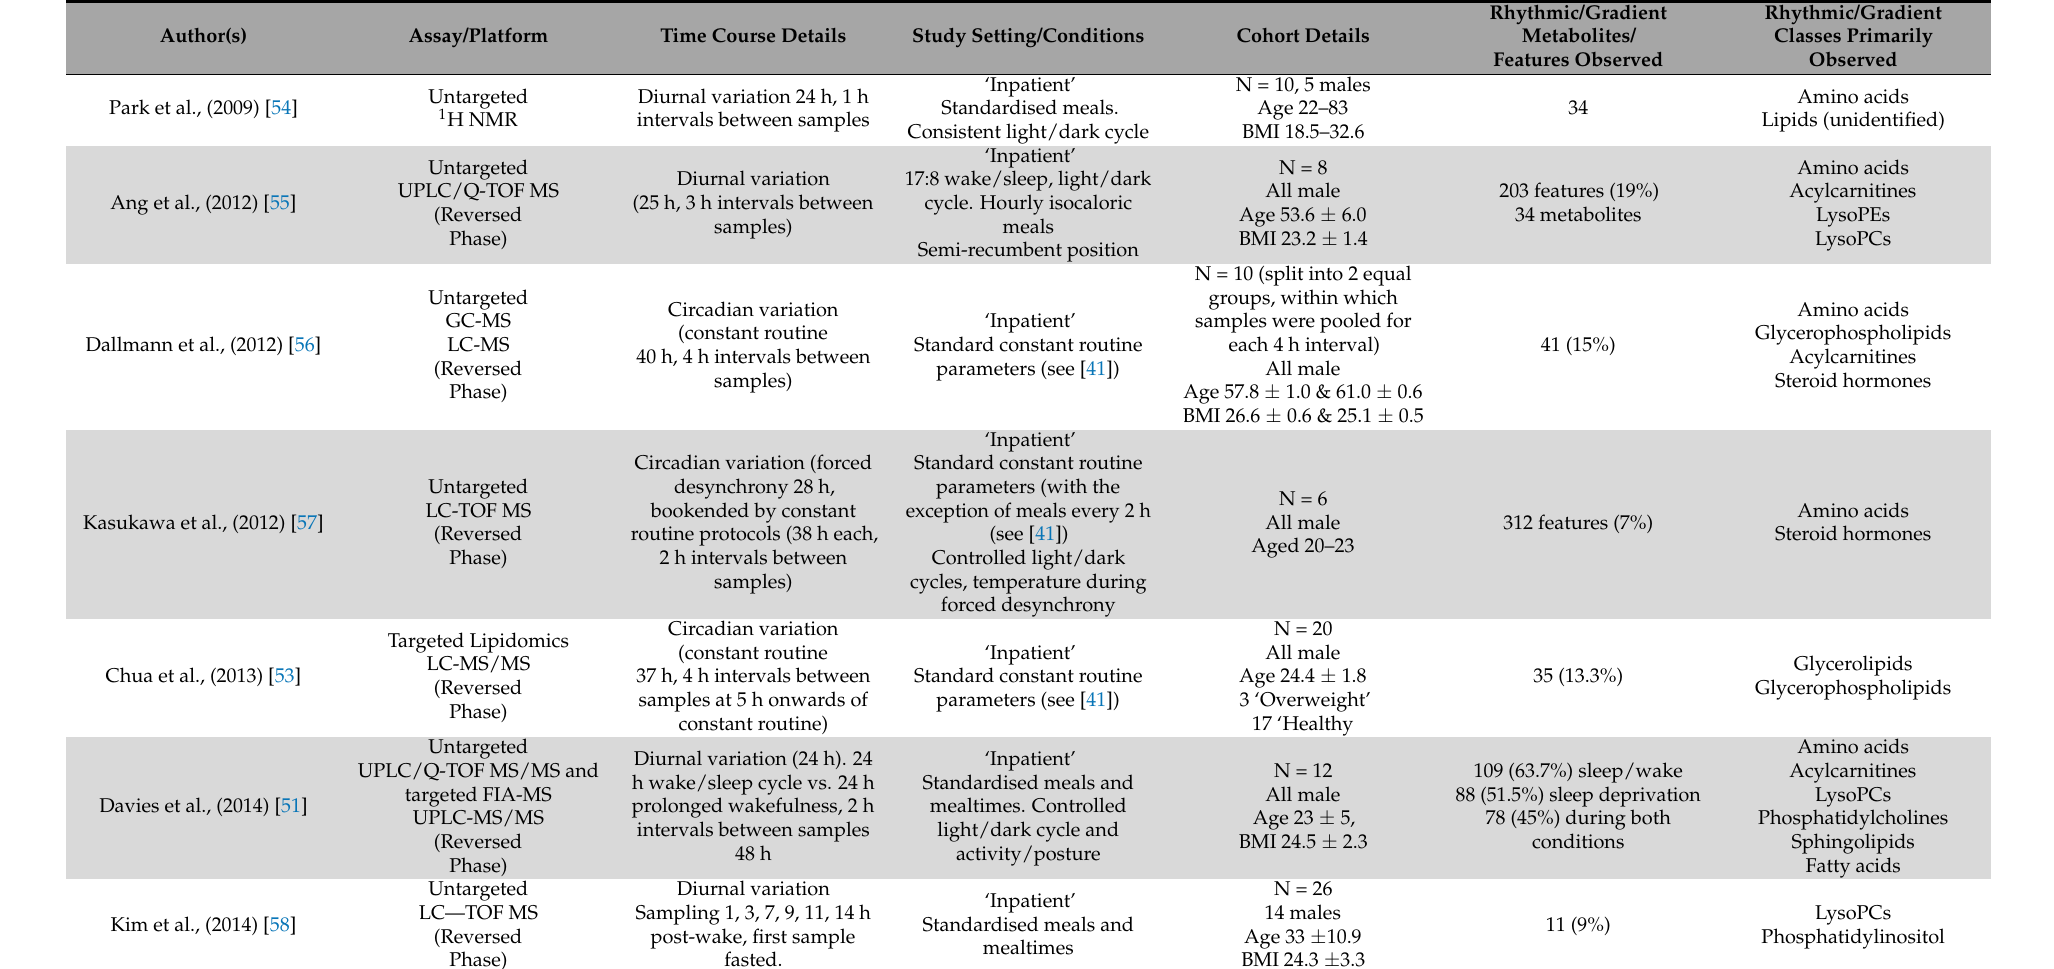
Table 2. A brief summary of study design, cohort details and results with regard to observed time of day variation of metabolites for relevant studies analysing